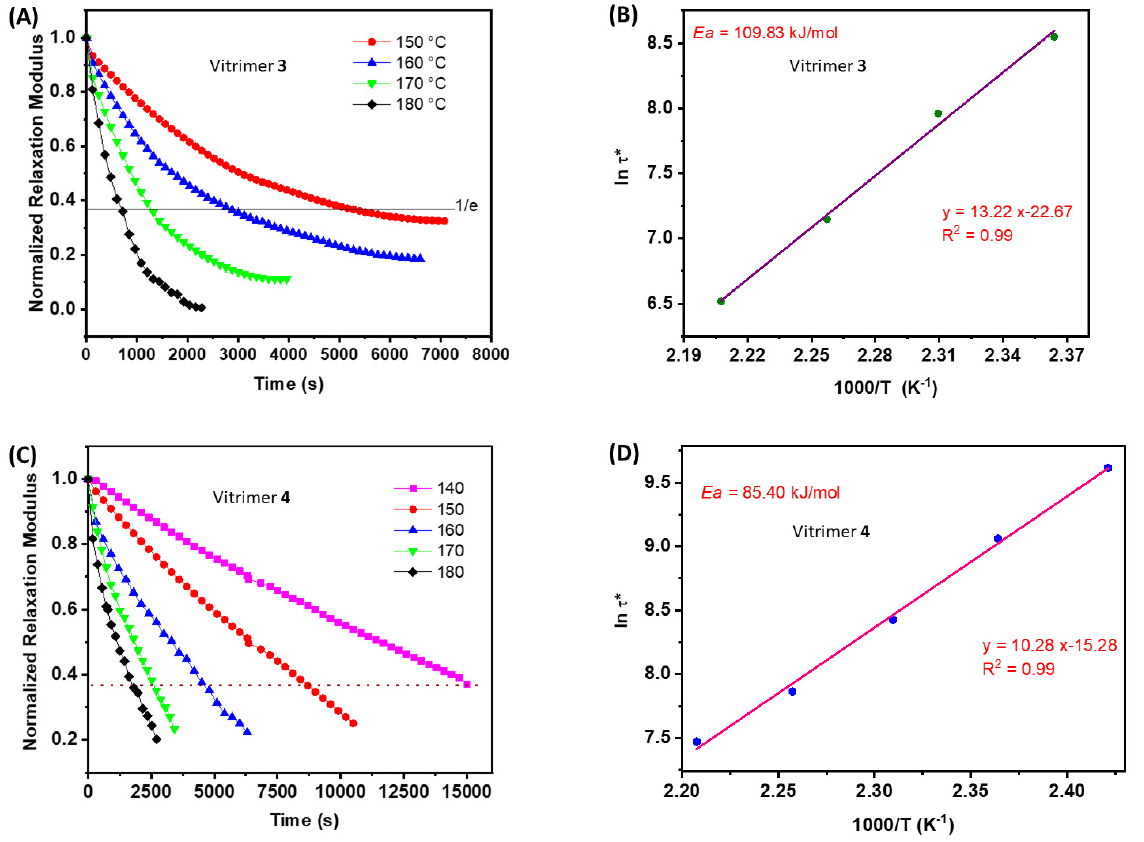
Figure 8. Normalized stress–relaxation curves of vitrimers, 3 ( A ) and 4 ( C ) at different temperature. Arrhenius analysis and the activation energy of vitrimers, 3 ( B ) and 4 ( D ). The dots are data points and lines represent their linear fit.